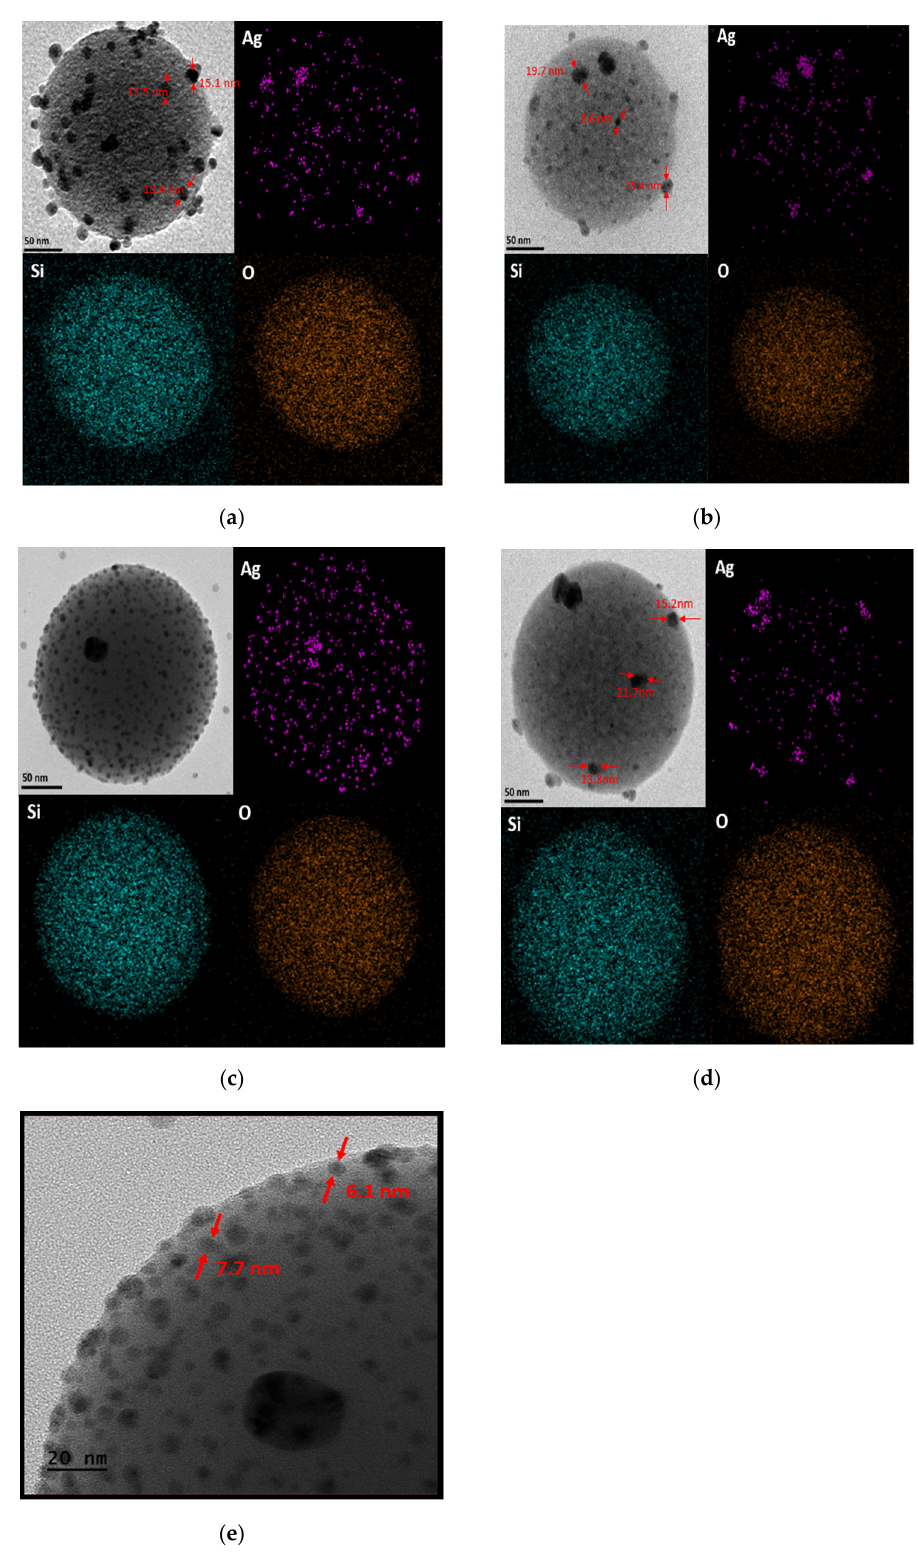
Figure 4. The HR-TEM and elemental mapping of ( a ) Ag-NH 2 -SiO 2 ( b ) Ag-SH-SiO 2 ( c ) Ag-OH − -SiO 2 ( d ) Ag-COOH-SiO 2 and ( e ) surface topography of Ag-OH − -SiO 2 .